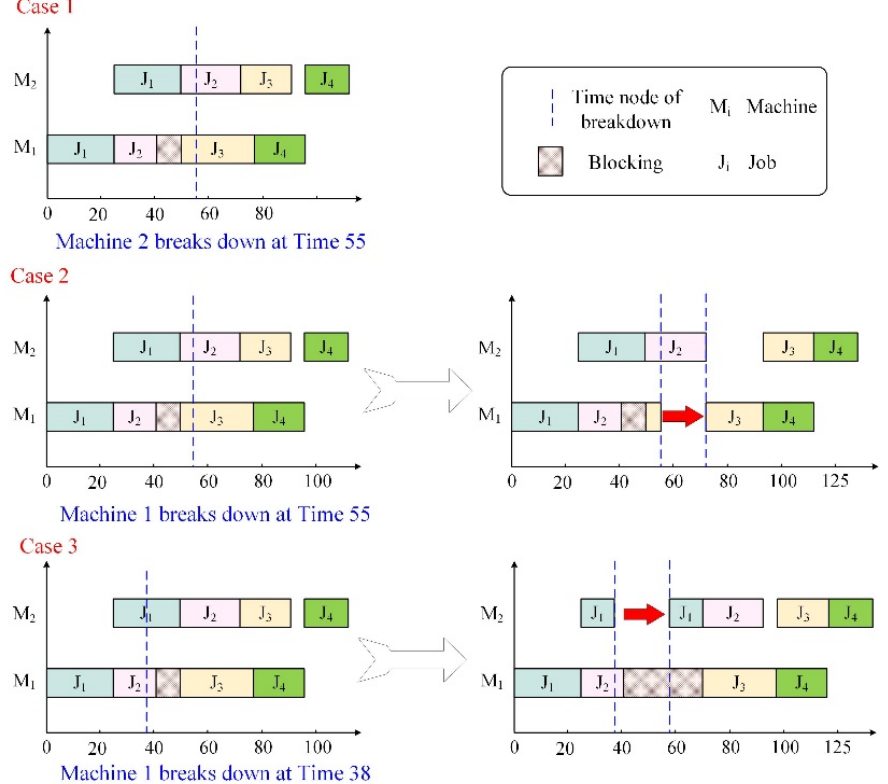
Figure 2. Classification of job status at machine breakdowns.